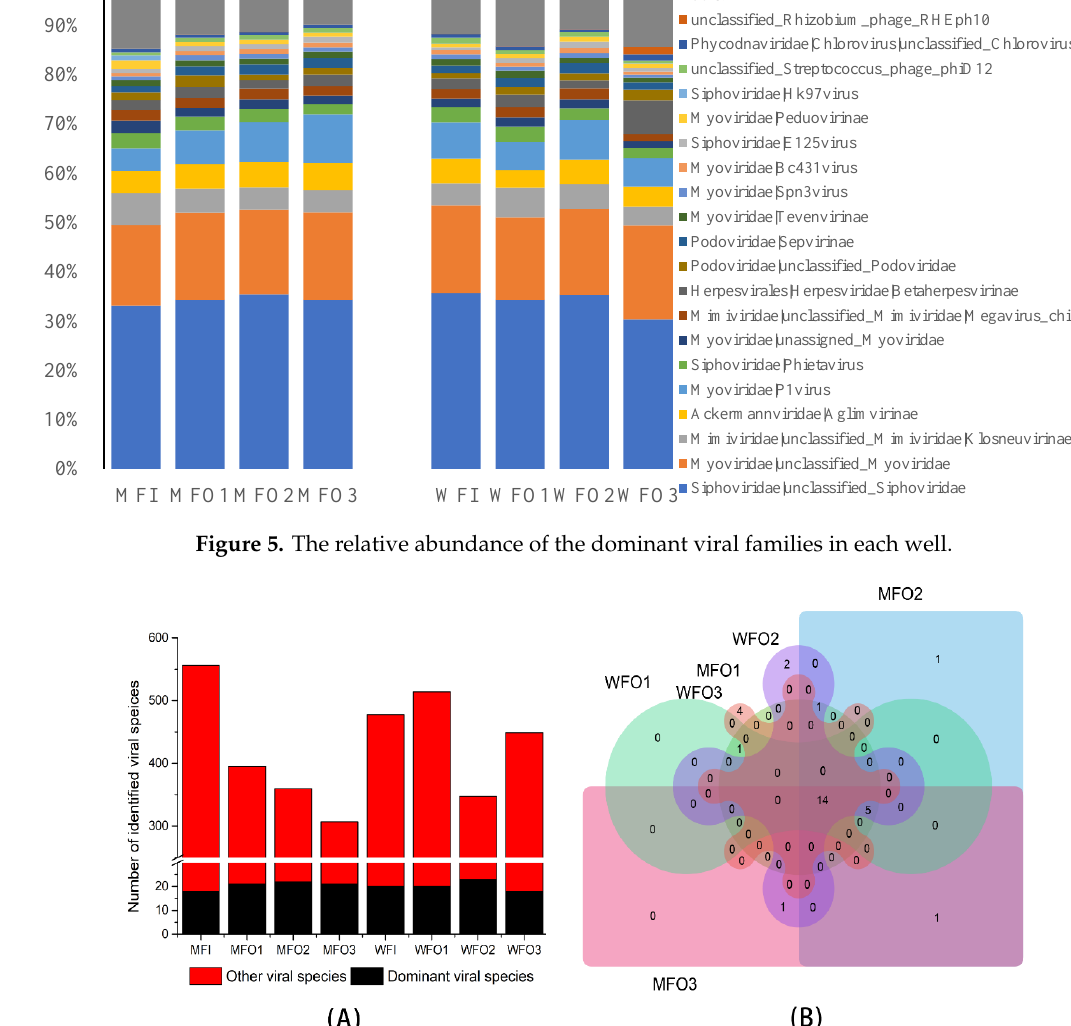
Figure 6. ( A ) The viral species richness in each production water sample, boxes with red represent dominant viral species of each sample that each viral relative abundance was more than 1%, and boxes with black represent the remaining viral species. ( B ) The number of shared or specific dominant viral species in production wells of water flooding and microbial flooding blocks.